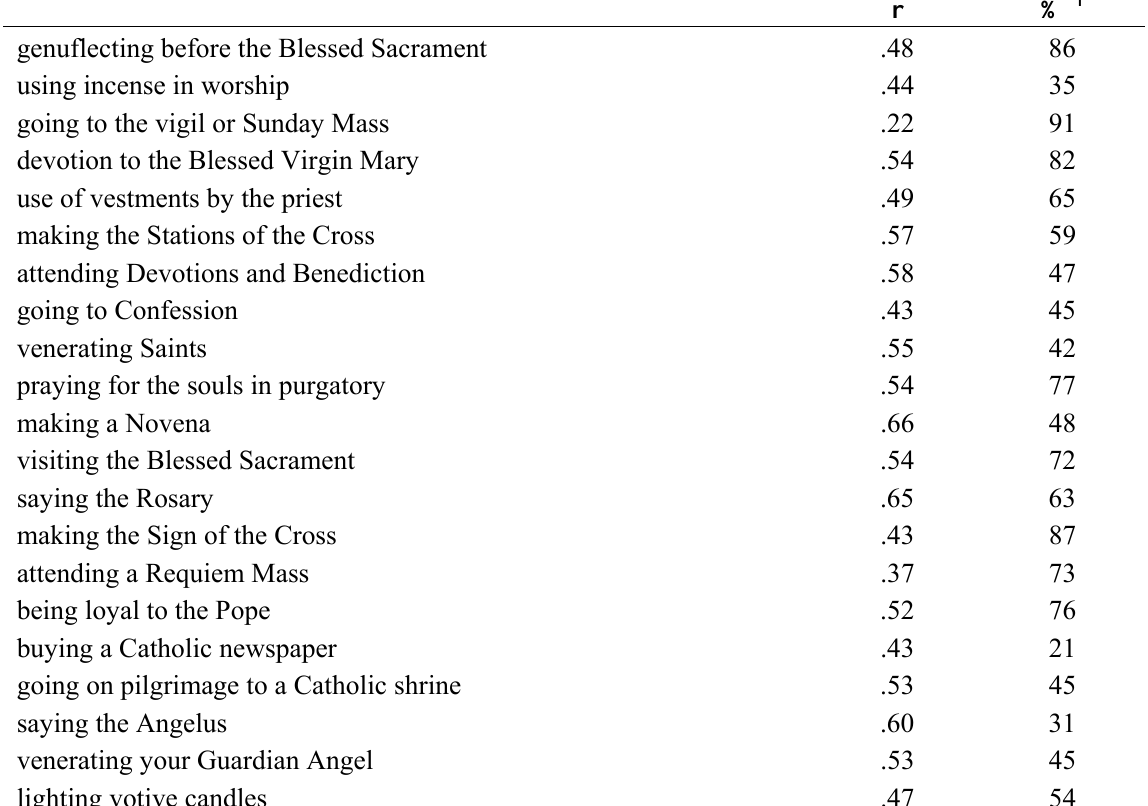
Table 2. Traditional Catholic Orientation Scale: item rest of scale correlations and item endorsement.